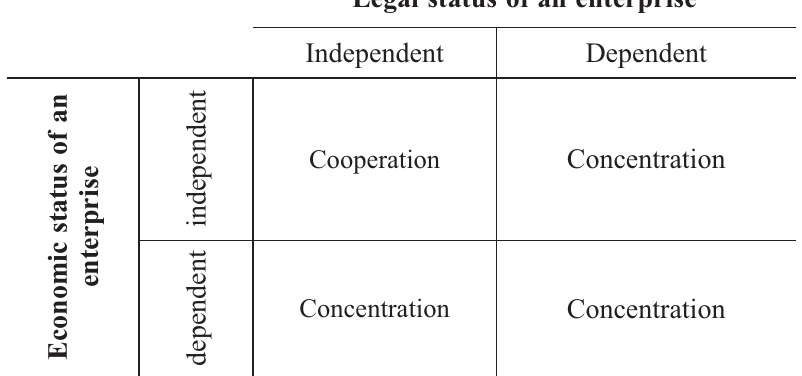
Fig. 1. Differences between concentration and